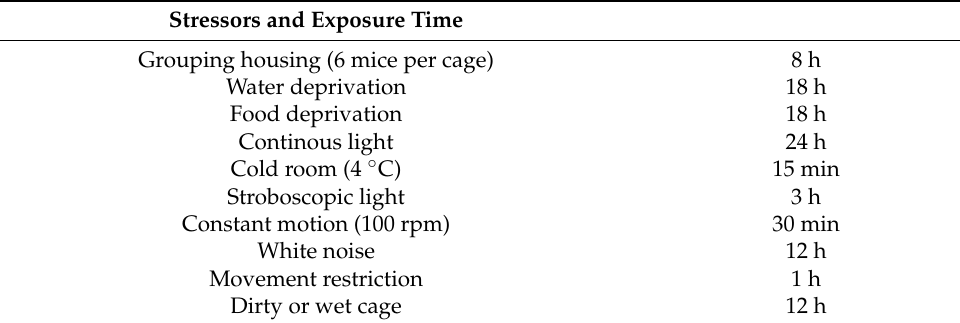
Table 1. Stressor used in the chronic mild stress paradigm. Stressors and Exposure